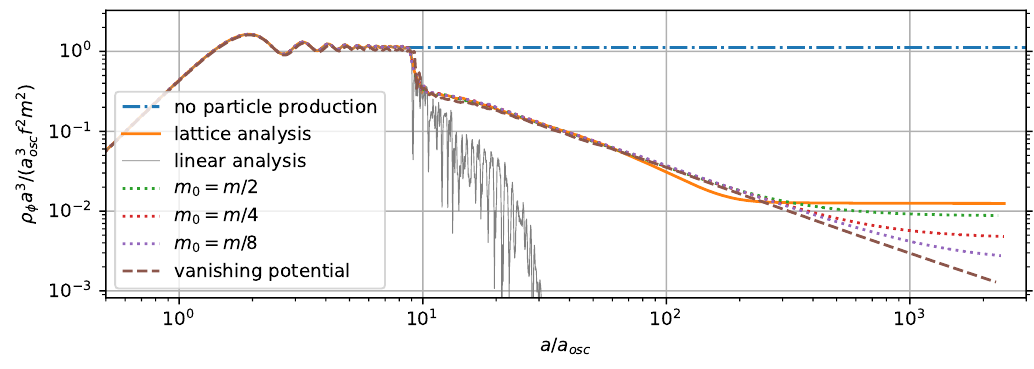
Figure 4: Evolution of the comoving axion energy density for θ = 1. Around a = a , osc the axion starts oscillating and scaling like matter ρ φ ≈ a − 3 m 2 f 2 . Without particle production, this scaling would persist (blue dot-dashed line) yielding the standard abundance from misalignment. For α = 60, the backreaction of dark photon produc- ∼ 9. The thin gray line shows the result from the tion becomes strong around a / a osc linear analysis, while the solid orange line gives the lattice result. The lattice result shows a suppression of the final axion abundance by ≈ 10 − 2 compared to the case with no particle production, in stark contrast to the linear analysis which suggests a much stronger suppresion. The dotted lines show possible further suppression in case where the final mass is adiabatically reduced, while the brown dashed line cor- = 100 (see Sec. 5 responds to a time dependent potential that vanishes around a / a osc for details).